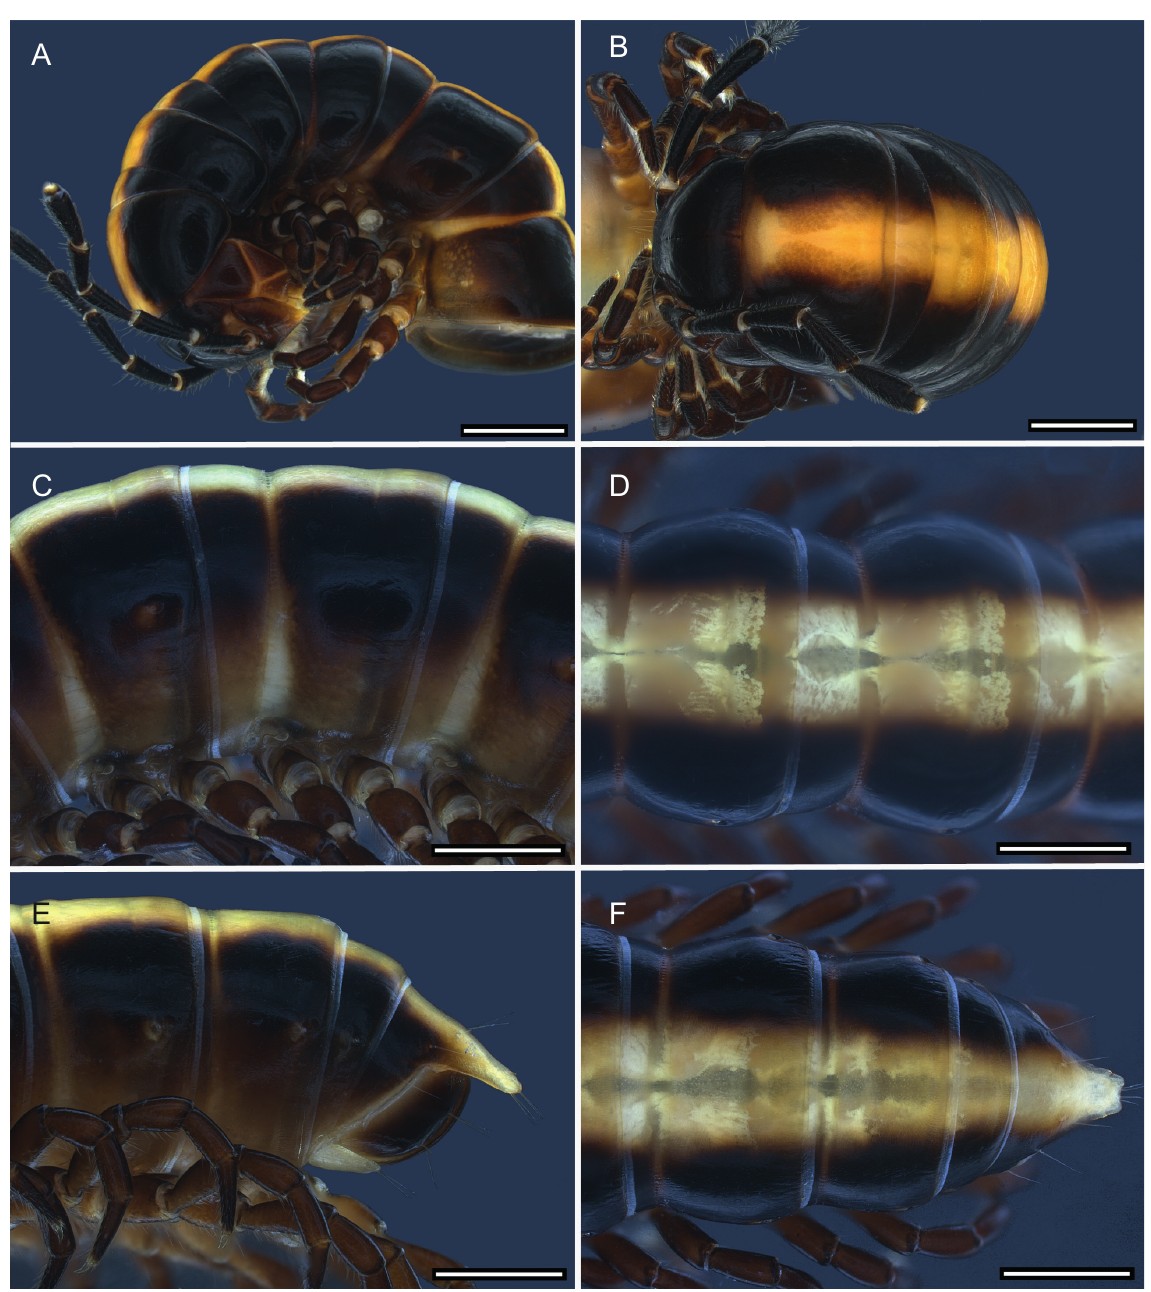
Fig. 22. Pogonosternum montanum Decker, sp. nov., ♂, from Batlow Road (NMV K-12184). A – B . Anterior rings A . Left lateral view. B . Dorsal view. C – D . Rings 10 and 11. C . Left lateral view. D . Dorsal view. E – F . Posterior rings. E . Left lateral view, F . Dorsal view. Scale bars: 1